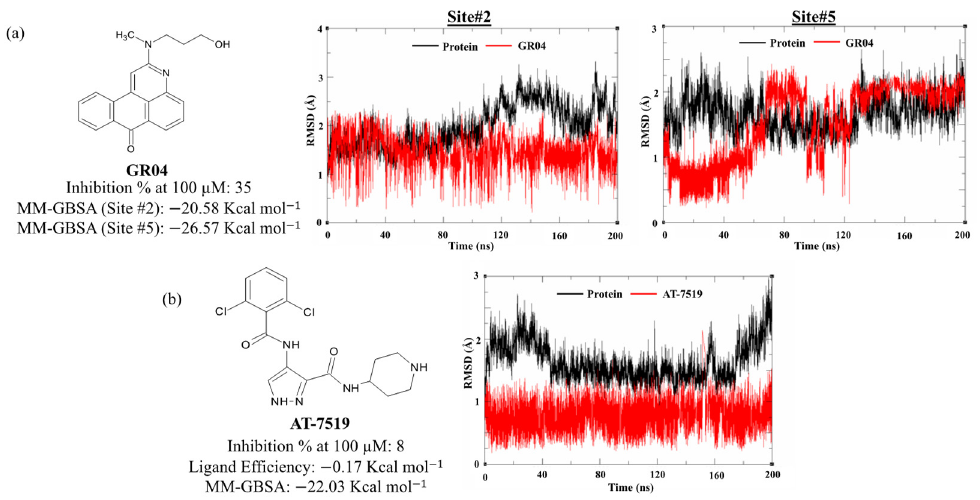
Figure 5. RMSD plot of the 200 ns MD simulations of ( a ) GR04 in sites #2 and #5 and ( b ) AT7519.